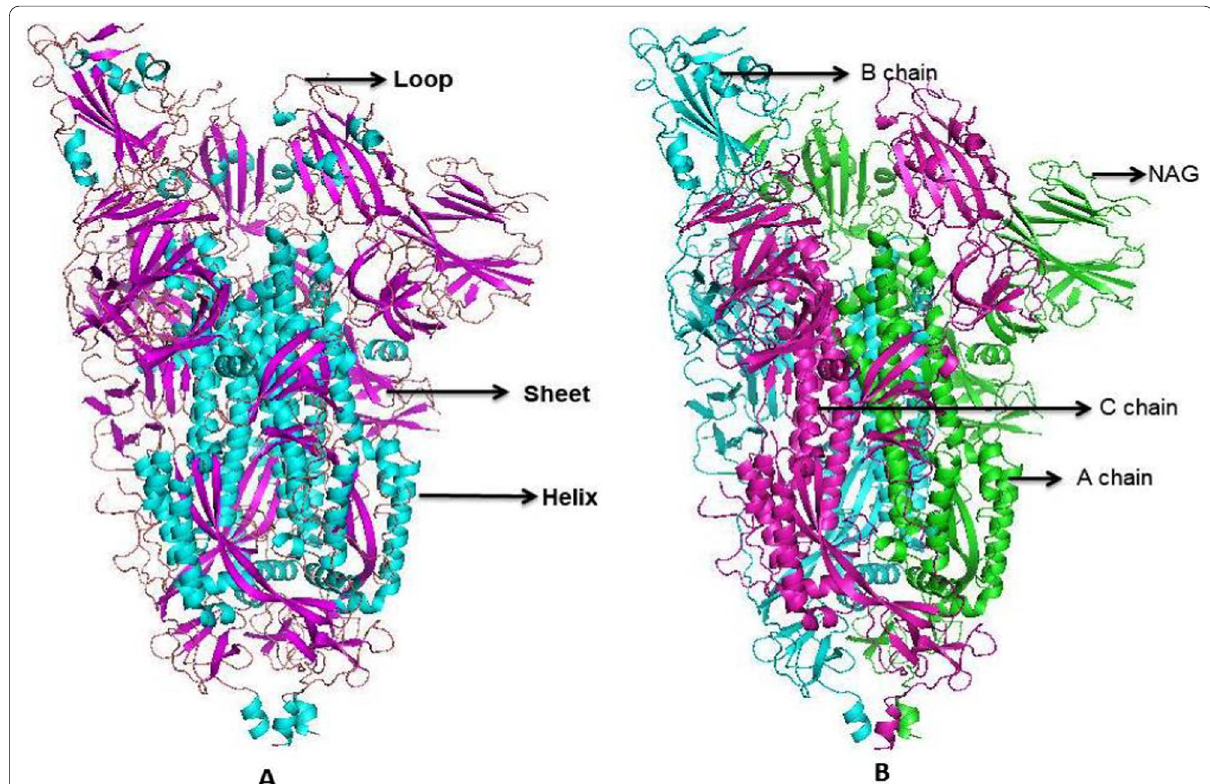
Fig. 5 A tertiary structure of spike (S) protein and Membrane (M) protein of SARS-CoV-2